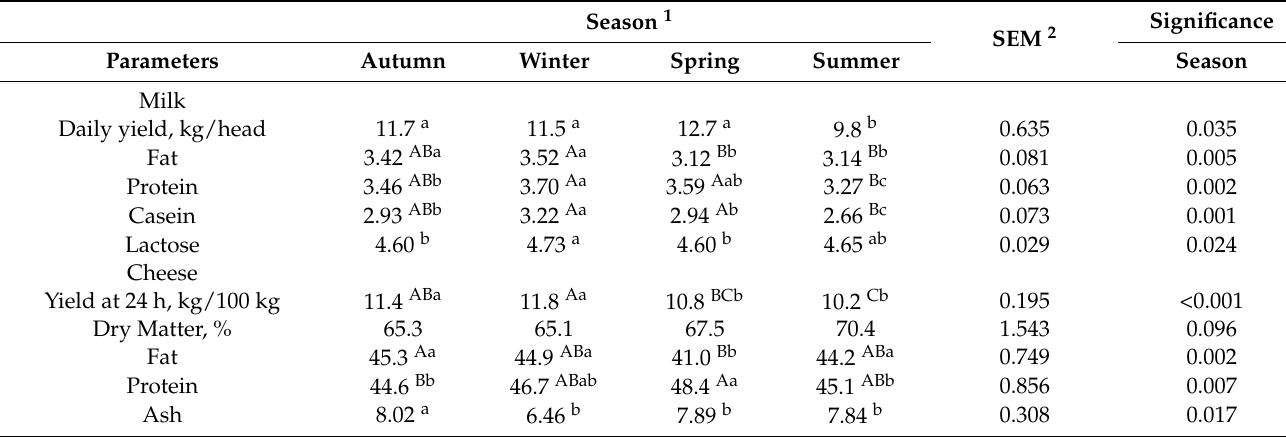
Table 3. Daily milk yield and chemical composition of raw milk (%) and Caciocavallo Palermitano cheese (% DM) in relation to the production